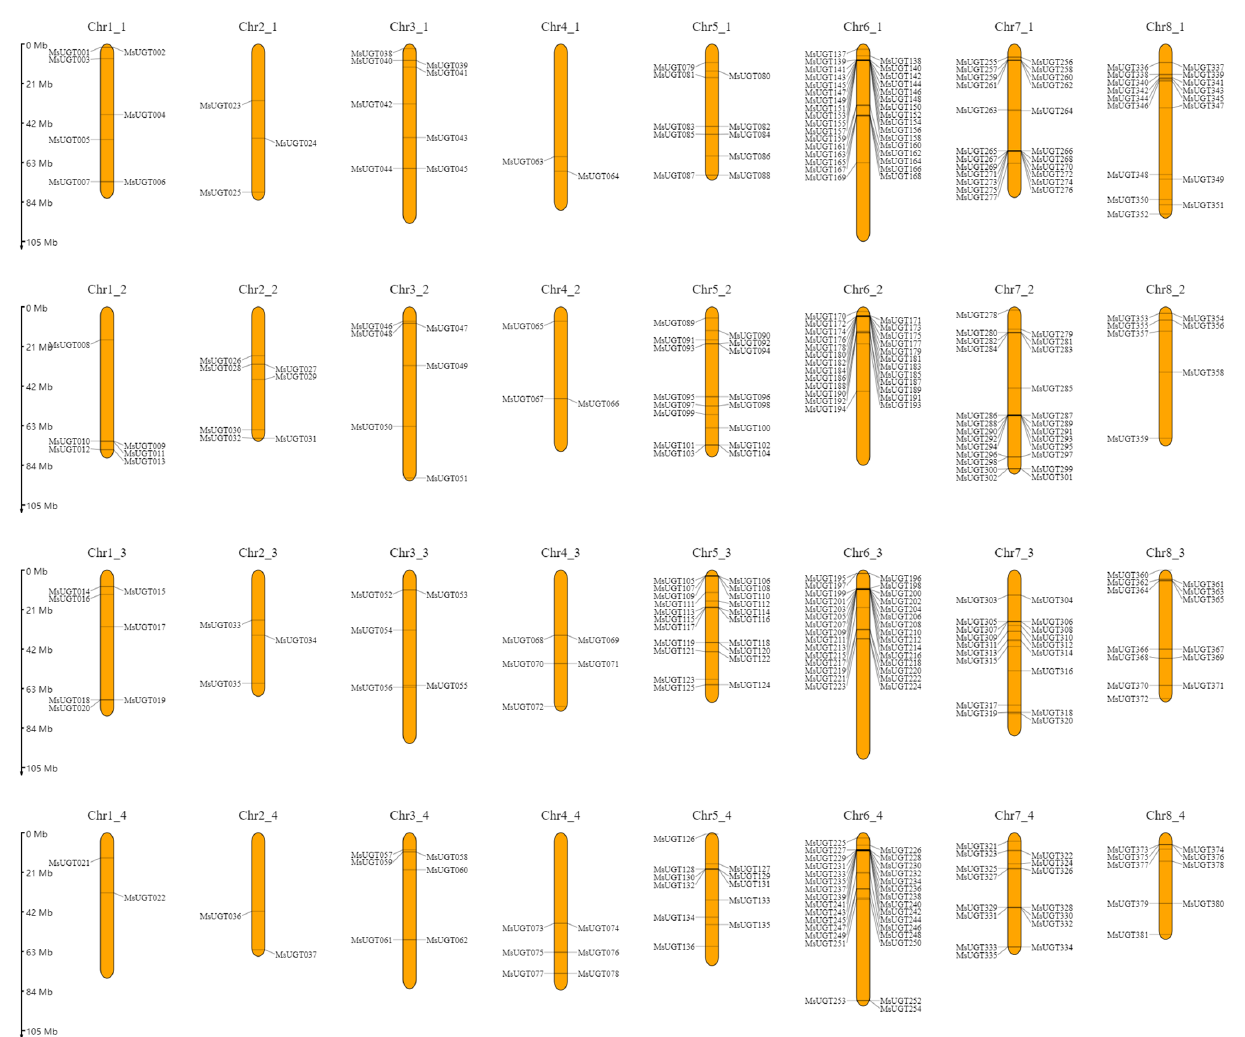
Figure 2. The physical location of MsUGT genes across the 32 chromosomes in the alfalfa genome. These genes were named MsUGT001 to MsUGT409 according to the physical distribution on the chromosomes. The orange bars represent 32 chromosomes, and the position of each MsUGT gene is indicated by the black lines.